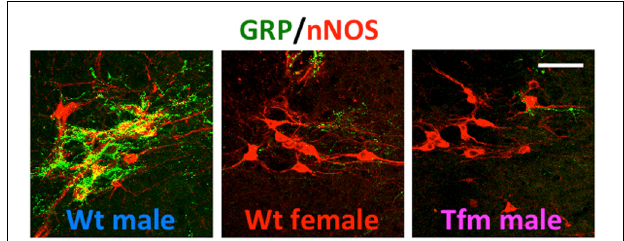
FIGURE 2 | A newly discovered sexual dimorphism in the lumbar spinal cord of rats that controls male sexual function. Co-immunofluorescence for gastrin-releasing peptide (GRP) (green) and neuronal nitric oxide synthase (nNOS) (red) confirmed that GRP-containing axons surrounding the autonomic sacral parasympathetic nucleus (SPN) neurons are significantly prominent in male rats, but vestigial or absent in females. In addition, testicular feminization mutation (Tfm) male rats display an entirely feminine pattern of GRP-containing fibers in the SPN autonomic nucleus. Wt, wild-type. Scale bar, 50 μ m. The figure was reproduced from Sakamoto et al. (2008) with